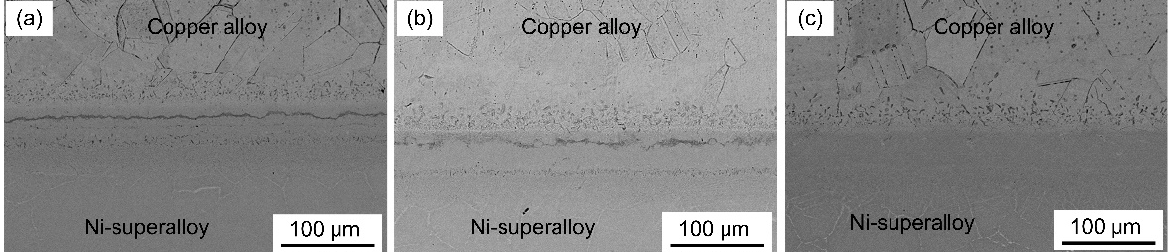
Figure 7. Microstructures of samples TLP-bonded within different bonding times: ( a ) 30 min, ( b ) 60 min, and ( c ) 90 min. Complete isothermal solidification was obtained when bonding at 1030 °C for 90 min.